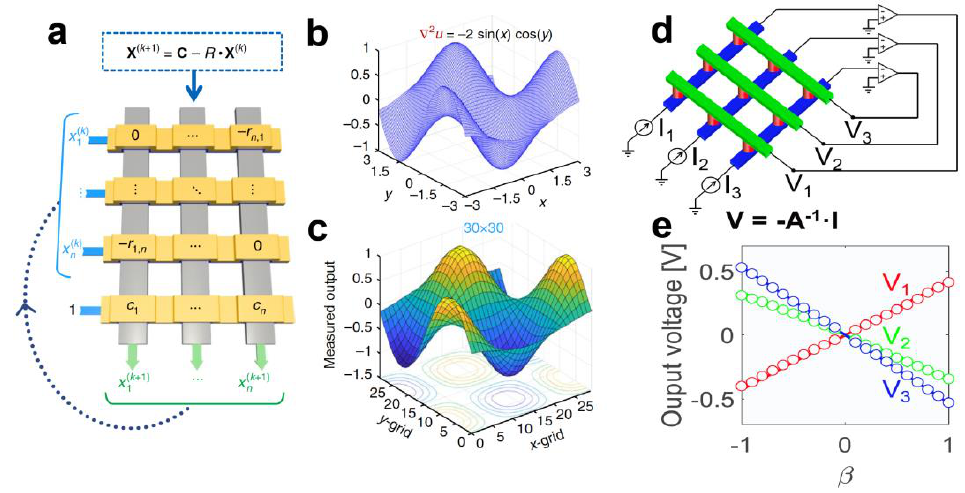
Figure 6. Memristor arrays for solving matrix-vector equations. ( a ) Memristor crossbar-based system for solving a Poisson’s equation. ( b , c ) The solution after 10 iterations shows an excellent match with the expected solution. Reproduced with permission. [71] Copyright 2018, Springer Nature. ( d ) Memristor cross-point circuit for solving matrix equations in one step. Circuits to calculate a scalar product I = G·V by Ohm’s law, and to calculate a scalar division V = −I/G by a TIA. ( e ) The parameter β to control the input current given by I = β [0.2; 1; 1] I 0 with −1 ≤ β ≤ 1. Reproduced with permission. [72] Copyright 2019, National Academy of Sciences.